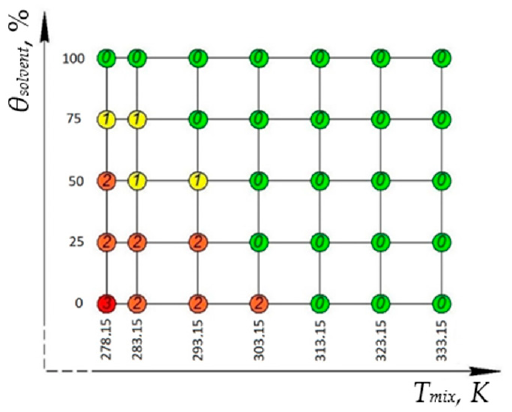
Figure 3. «Map» of rheological models of bituminous and low-viscosity oil mixture from the Ashalchinsky field at different temperatures and concentrations of